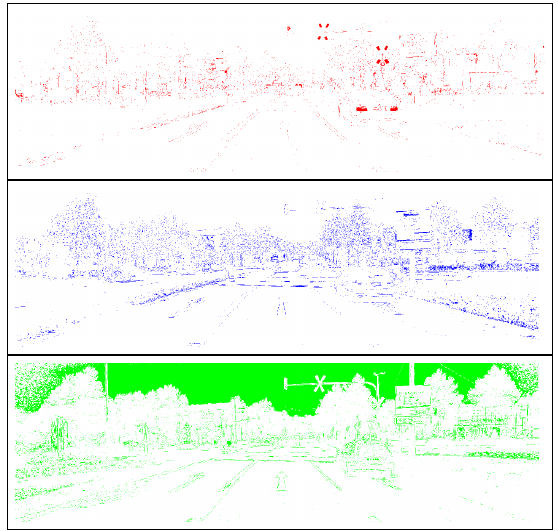
Figure 3: The red, yellow, and green objects are selected using threshold on the hue component of HSL color space. Yellow channel is shown in blue for better visualization. Noise in color, which is unavoidable in inexpensive cameras, can create salt and pepper noise after the color mask is applied. A median filter is used to remove these fictitious red, yellow, and green pixels. The filtered image when the median filter is applied is shown in Figure